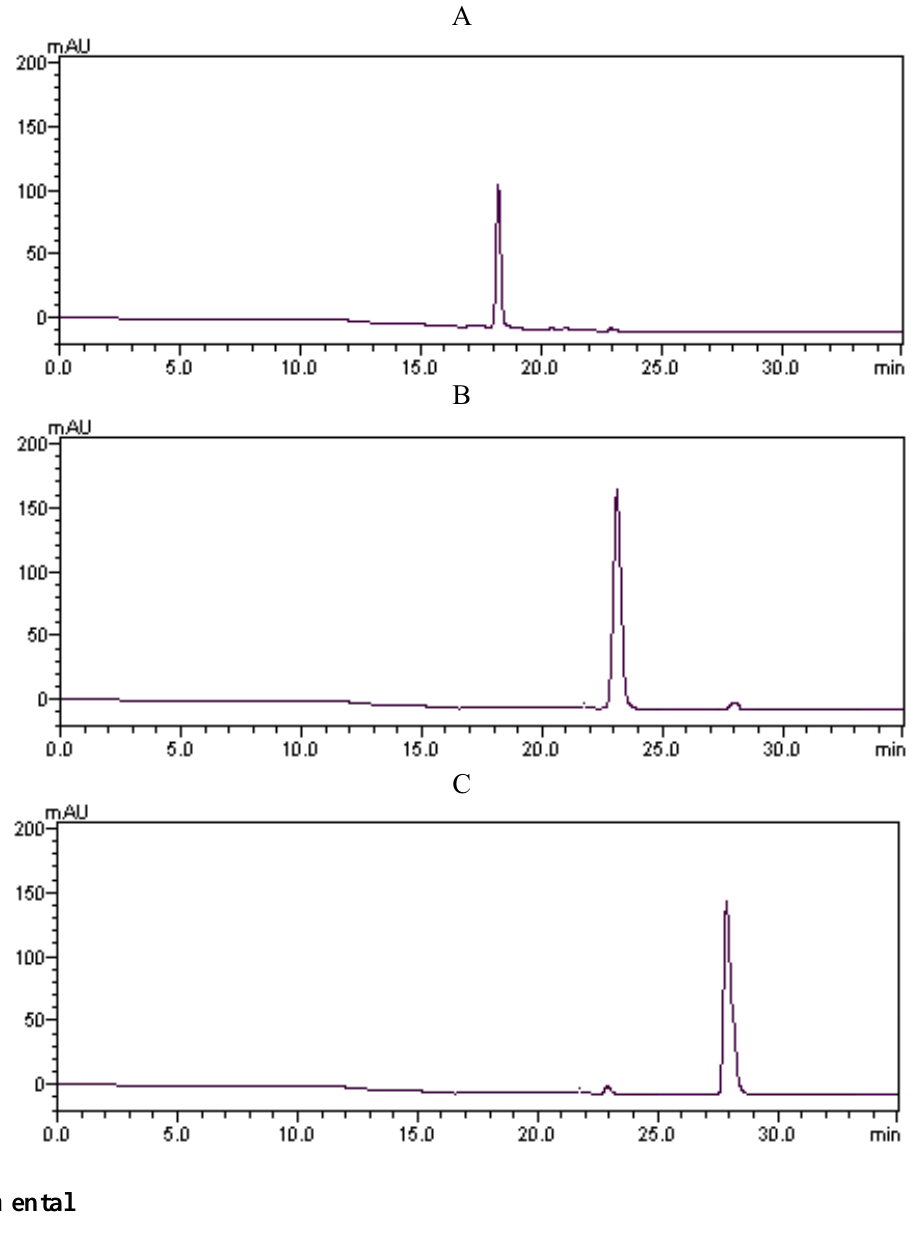
Figure 4. HPLC chromatograms of the HSCCC fractions. A: emodin from HSCCC fraction I; B: chrysophanol from HSCCC fraction II, and C: physcion from HSCCC fraction